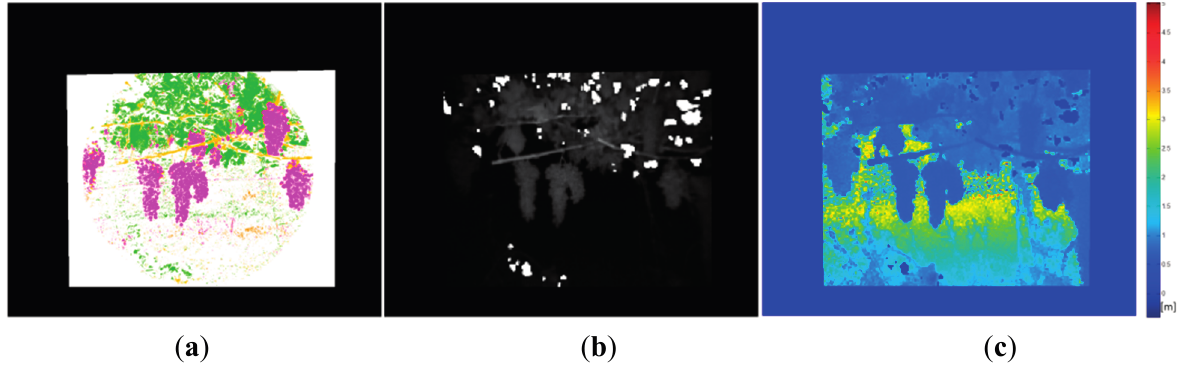
Figure 13. Registered data – Vineyard. ( a ) Registered multispectral map; ( b ) TOF registered amplitude data; ( c ) TOF registered Z-axis range data.